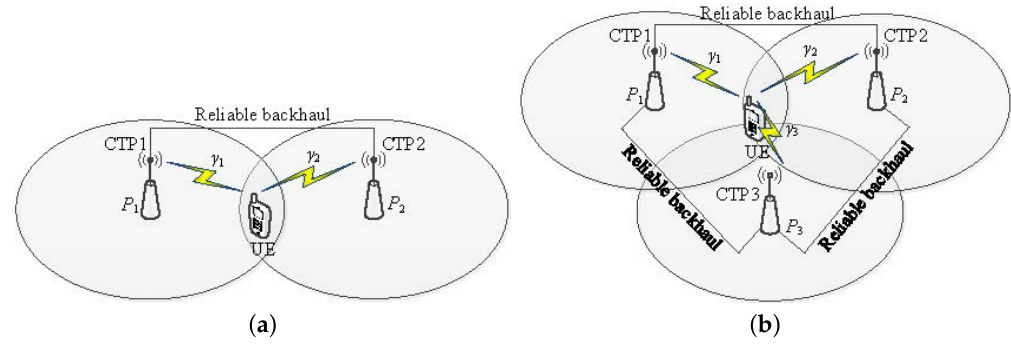
Figure 1. CoMP JDT networks: ( a ) Co2P case ( b ) Co3P